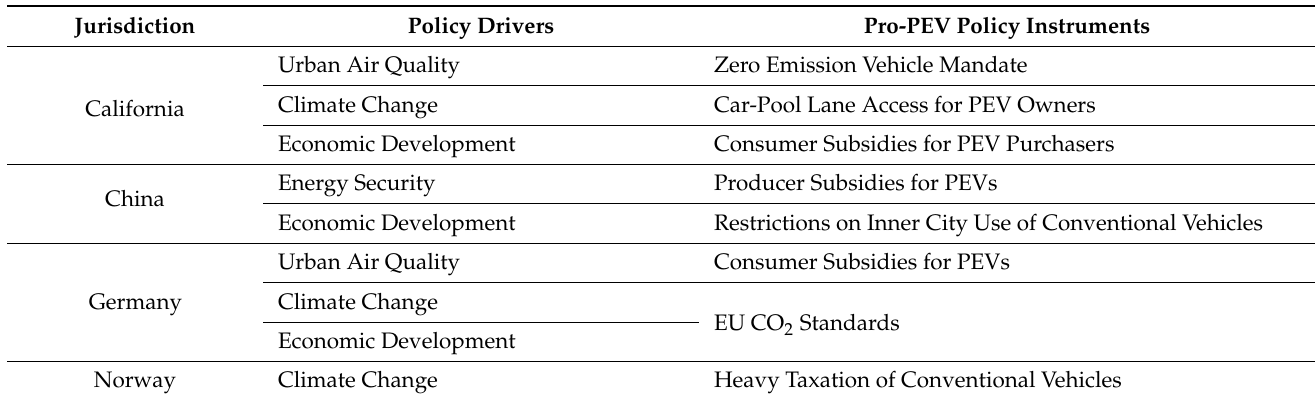
Table 7. Summary of distinctive pro-PEV policy drivers and policy instruments in California, China, Germany and Norway.